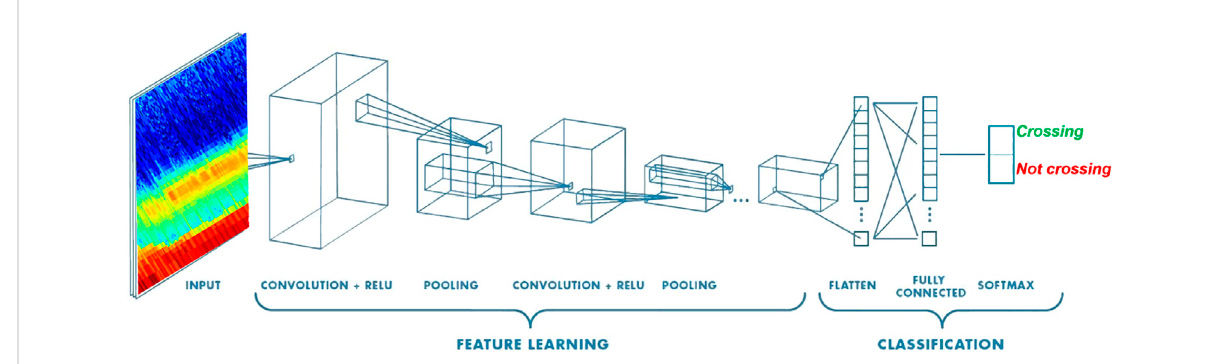
FIGURE 7 Diagram showing howaninput imageofCAPS ELSenergy spectrogram ispassed throughaCNN modeland isclassi fi edasbeinga ‘ crossing ’ or ‘ notCrossing ’